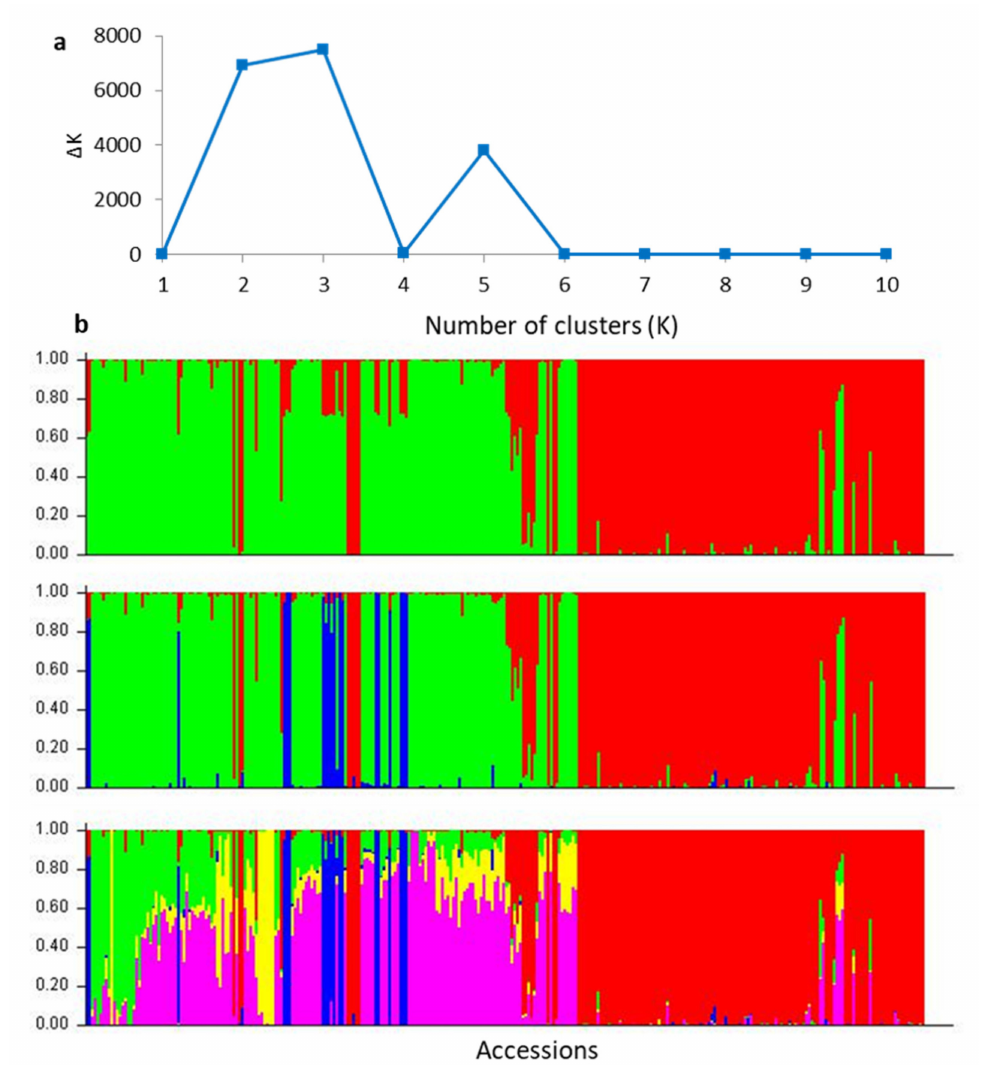
Figure 2. Population structure of 302 accessions based on 2872 SNPs, as inferred by STRUCTURE. ( a ) Best value of K based on Evanno’s ∆ K; ( b ) Individual membership proportions (Q value) in two, three and five clusters, with each cluster represented by a colour block. Each vertical line represents one accession. The accessions were sorted on the x-axis by latitude from north to